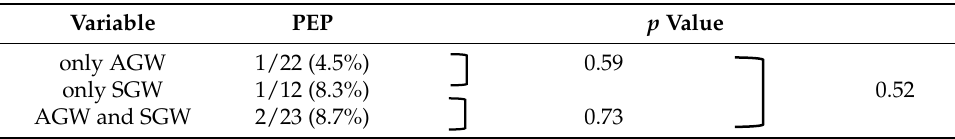
Table 5. Final PEP rates. Table 5. Final PEP